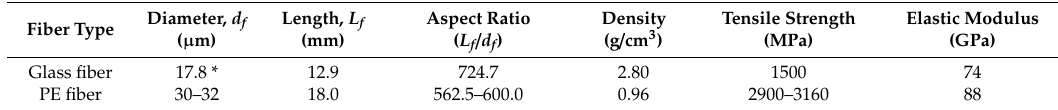
Table 1. Properties of the glass and PE fibers.